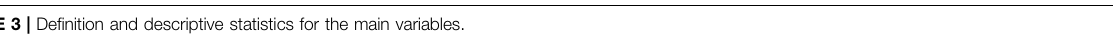
TABLE 3 | De fi nition and descriptive statistics for the main